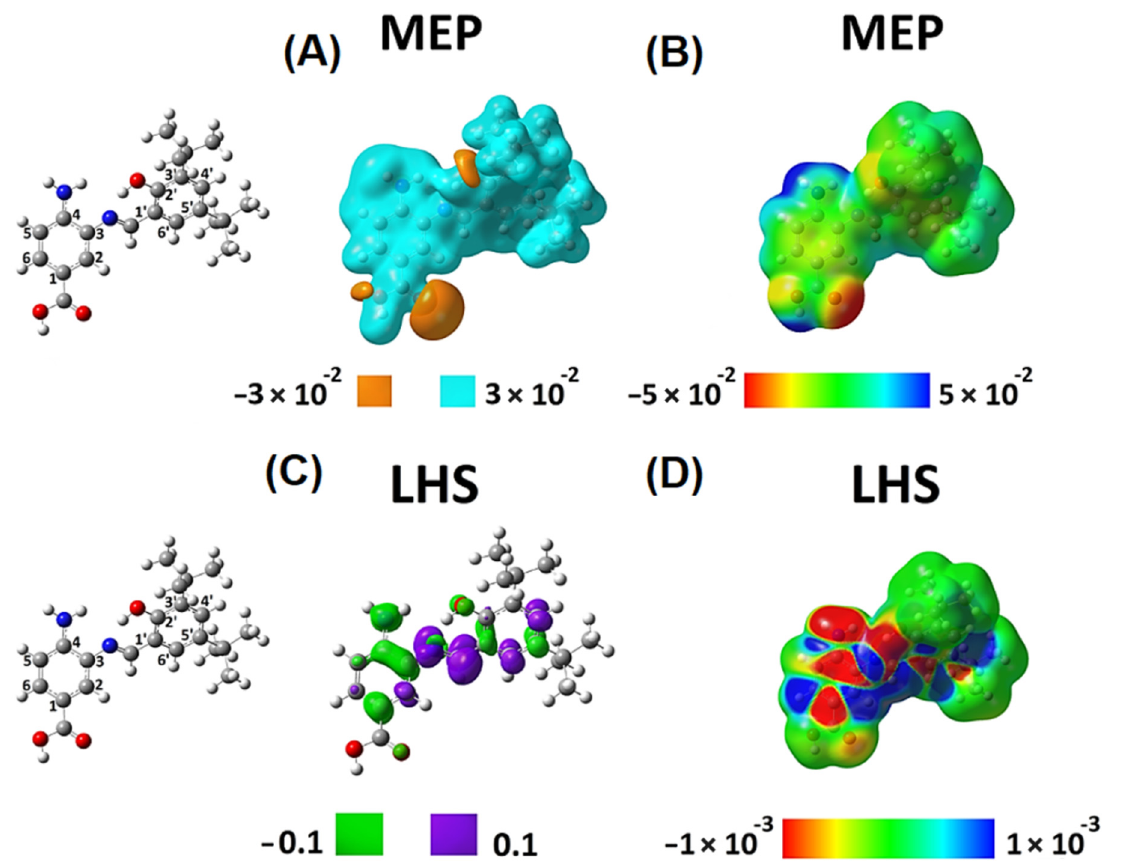
Figure 4. Local reactivity descriptors of SB-1. Molecular electrostatic potential (MEP) and local hyper softness (LHS) values as 3D pictures. Isovalues of MEP are displayed at ± 0.03 hartree · e − 1 (or ± 0.03 a.u.) ( A ), and isovalues of LHS are displayed at ± 0.1 e 3 · hartree − 2 · bohr − 3 (or ± 0.1 a.u.) for LHS ( C ). Values of MEP and LHS projected onto at an electron density isosurface of 0.001 e · bohr − 3 ranging from − 0.05 to 0.05 hartree · e − 1 ( B ) and from − 0.001 to 0.001 e 3 · hartree − 2 · bohr − 3 ( D ) are depicted, respectively. The corresponding atom numbering is shown on the left.